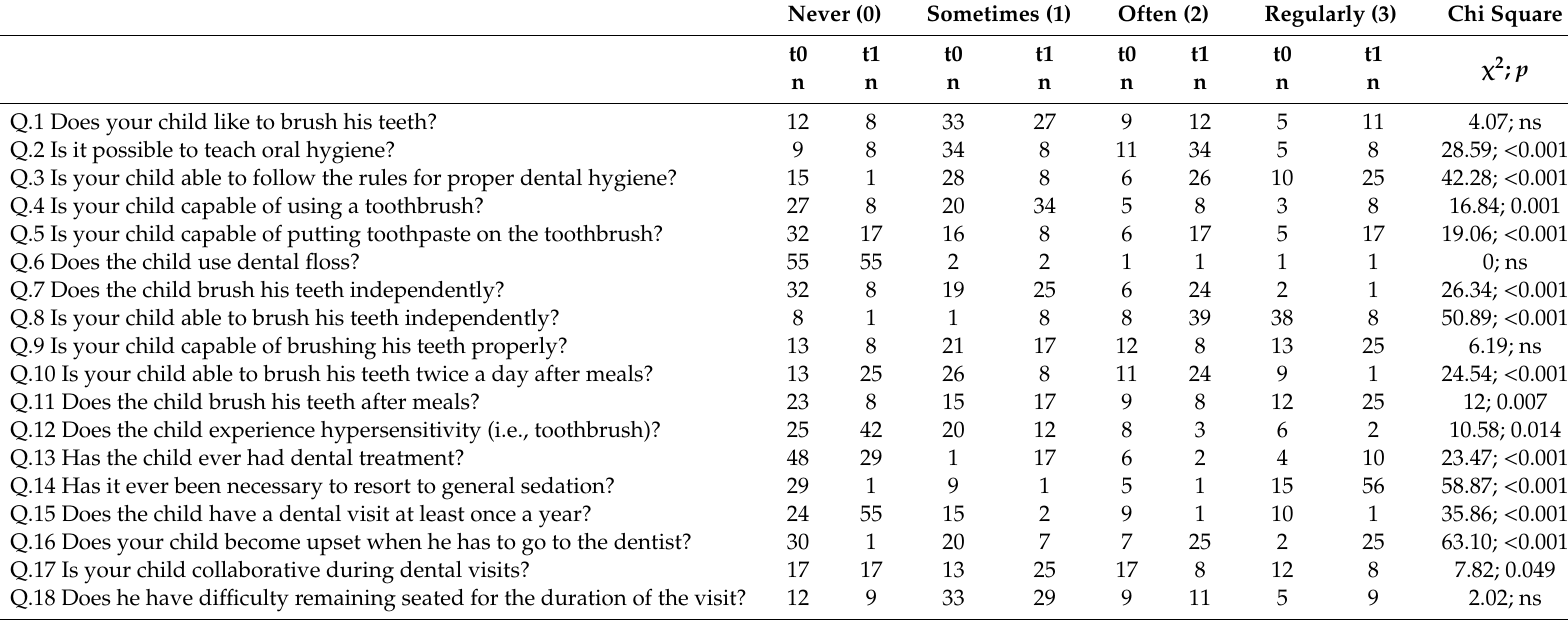
Table 2. Chi Square results between T0 and T1 at Questionnaire